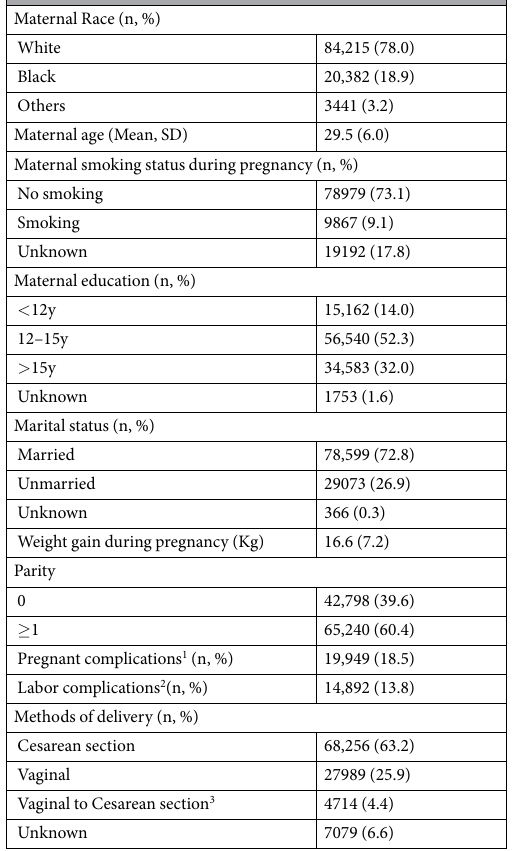
Table 1. Baseline Characteristics of the Mothers of Mixed-Gender Twins. 1 Defined as one or more of the following diseases or conditions: anemia (HCT < 30 or Hb < 100 g/L), cardiac disease; acute or chronic lung disease, diabetes, hydramnios or oligohydramnios, hemoglobinophathy, chronic or pregnancy-associated hypertension, and renal disease. 2 Defined as one or more of the following diseases or conditions: premature rupture or membrane > 12 hours, abruption placenta, placenta previa, precipitous or prolong labor, dysfunctional labor, seizure during labor, cephalopelvic disproportion, and excessive bleeding. 3 The first babies were vaginal delivery and the second ones by cesarean